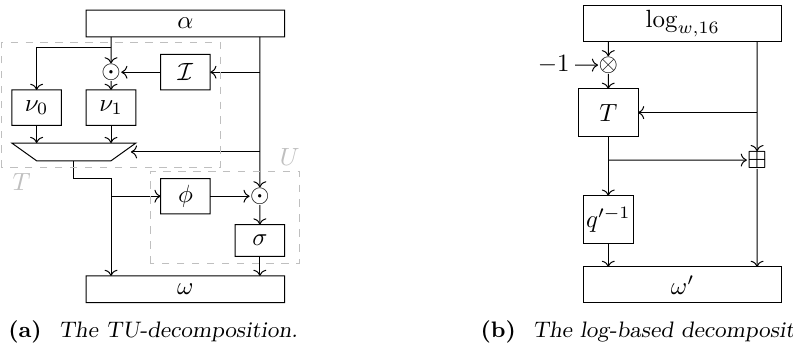
Figure 1: The decompositions of 𝜋 in the